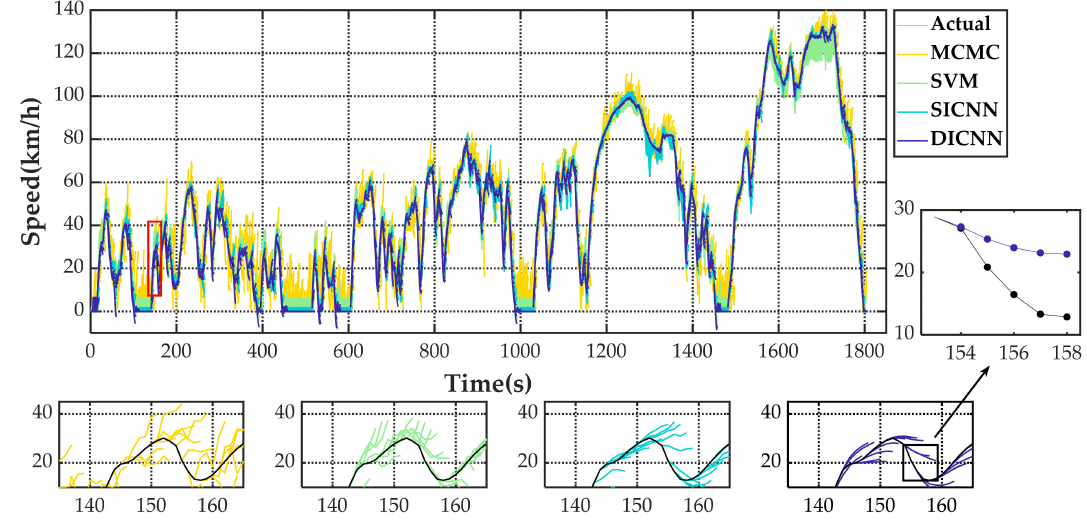
Figure 5. The speed prediction results of four methods for WLTC. The dots (lines) with color are predicted values and the black dots (lines) are actual values.